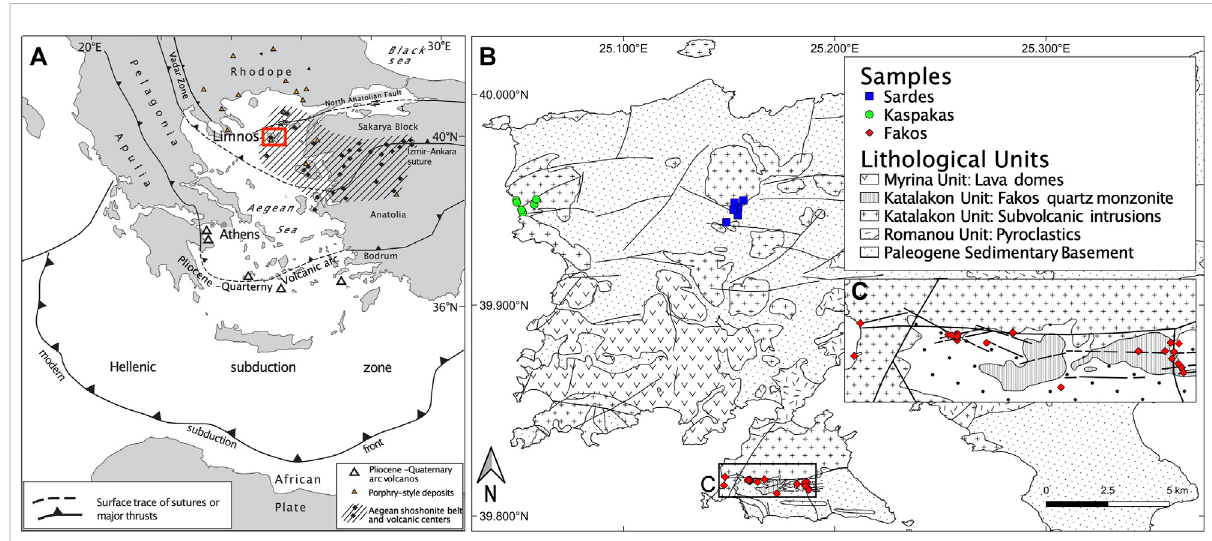
FIGURE 1 (A) Geographical overview, major tectonic units and porphyry-style deposits in the Aegean region. Modi fi ed after Pe-Piper et al. (2009), Baker (2019) and Voudouris et al. (2019b). The red rectangle outlines the location of Limnos Island in the Aegean shoshonite belt. (B) Simpli fi ed geological map of Limnos Island highlighting the different lithological units after Innocenti et al. (1994) and Pe-Piper et al. (2009). The different porphyry- epithermalsystemsandrelatedsamplelocations(Table1)arepresentedbythereddiamonds(Fakos),greencircles(Kaspakas),andbluesquares (Sardes); (C) Detailed map of